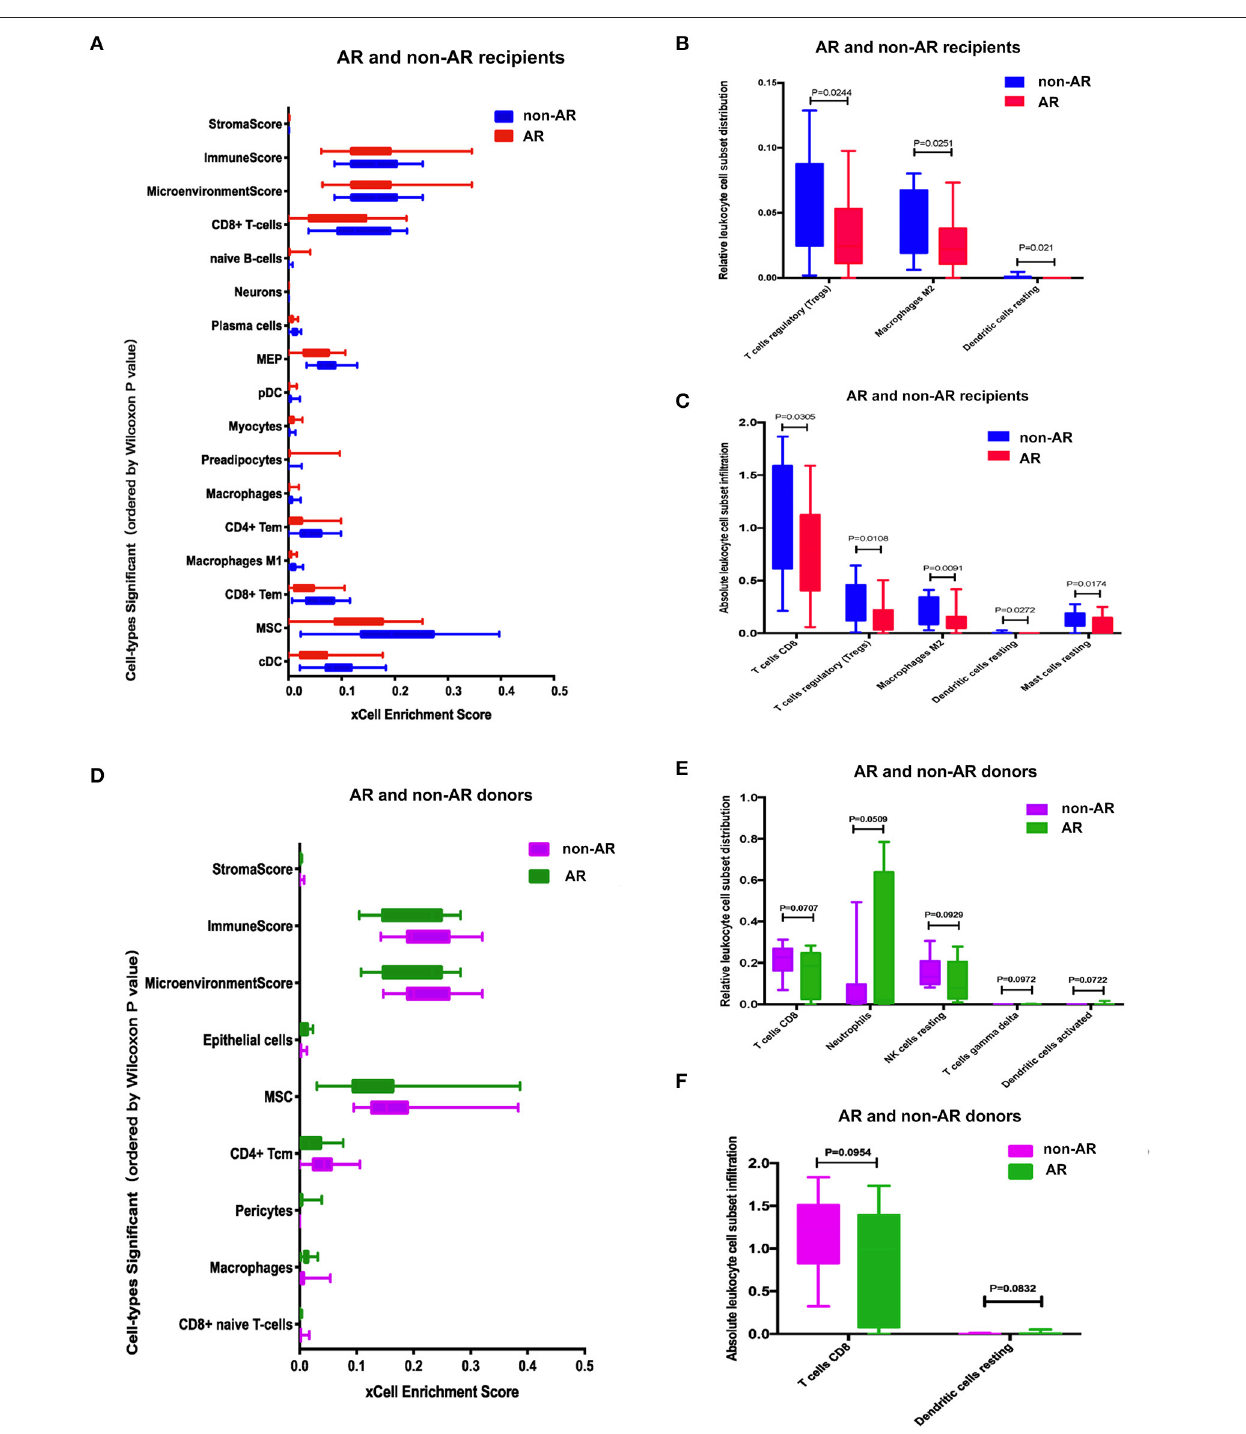
FIGURE 5 | Cell-type enrichment analysis using xCell and CIBERSORT. (A) Cell-type enrichment analysis of the recipients RNA-Seq data determined using xCell, a bioinformatics tool that generates cell-type ESs based on gene expression data for 64 immune and stromal cell types. The x -axis depicts the xCell ES, and the y -axis lists 14 of the 64 cell types that were differentially enriched (FDR < 0.1, Wilcoxon test with Benjamini-Hochberg correction) in AR vs. non-AR recipients. Box plots of the immune score (composite score of immune cell types) and the microenvironment score (composite scores of immune cell types and stromal cell types) are also shown. (B, C) Immune cell enrichment analysis of the recipients using CIBERSORT. The bar chart shows the relative (B) and absolute (C) leukocyte cell subset population differences between AR and non-AR recipients. The population percentages of CD8 + T cells and Tregs were deconvoluted from the RNA-Seq using the expression profiles of sorted immune cells. (D) Cell type enrichment analysis using xCell between donors with AR and non-AR. (E–F) Immune cell enrichment analysis of the donors using Cibersort. The bar chart shows the relative (E) and absolute (F) leukocyte cell subset population differences between donors with AR and non-AR.